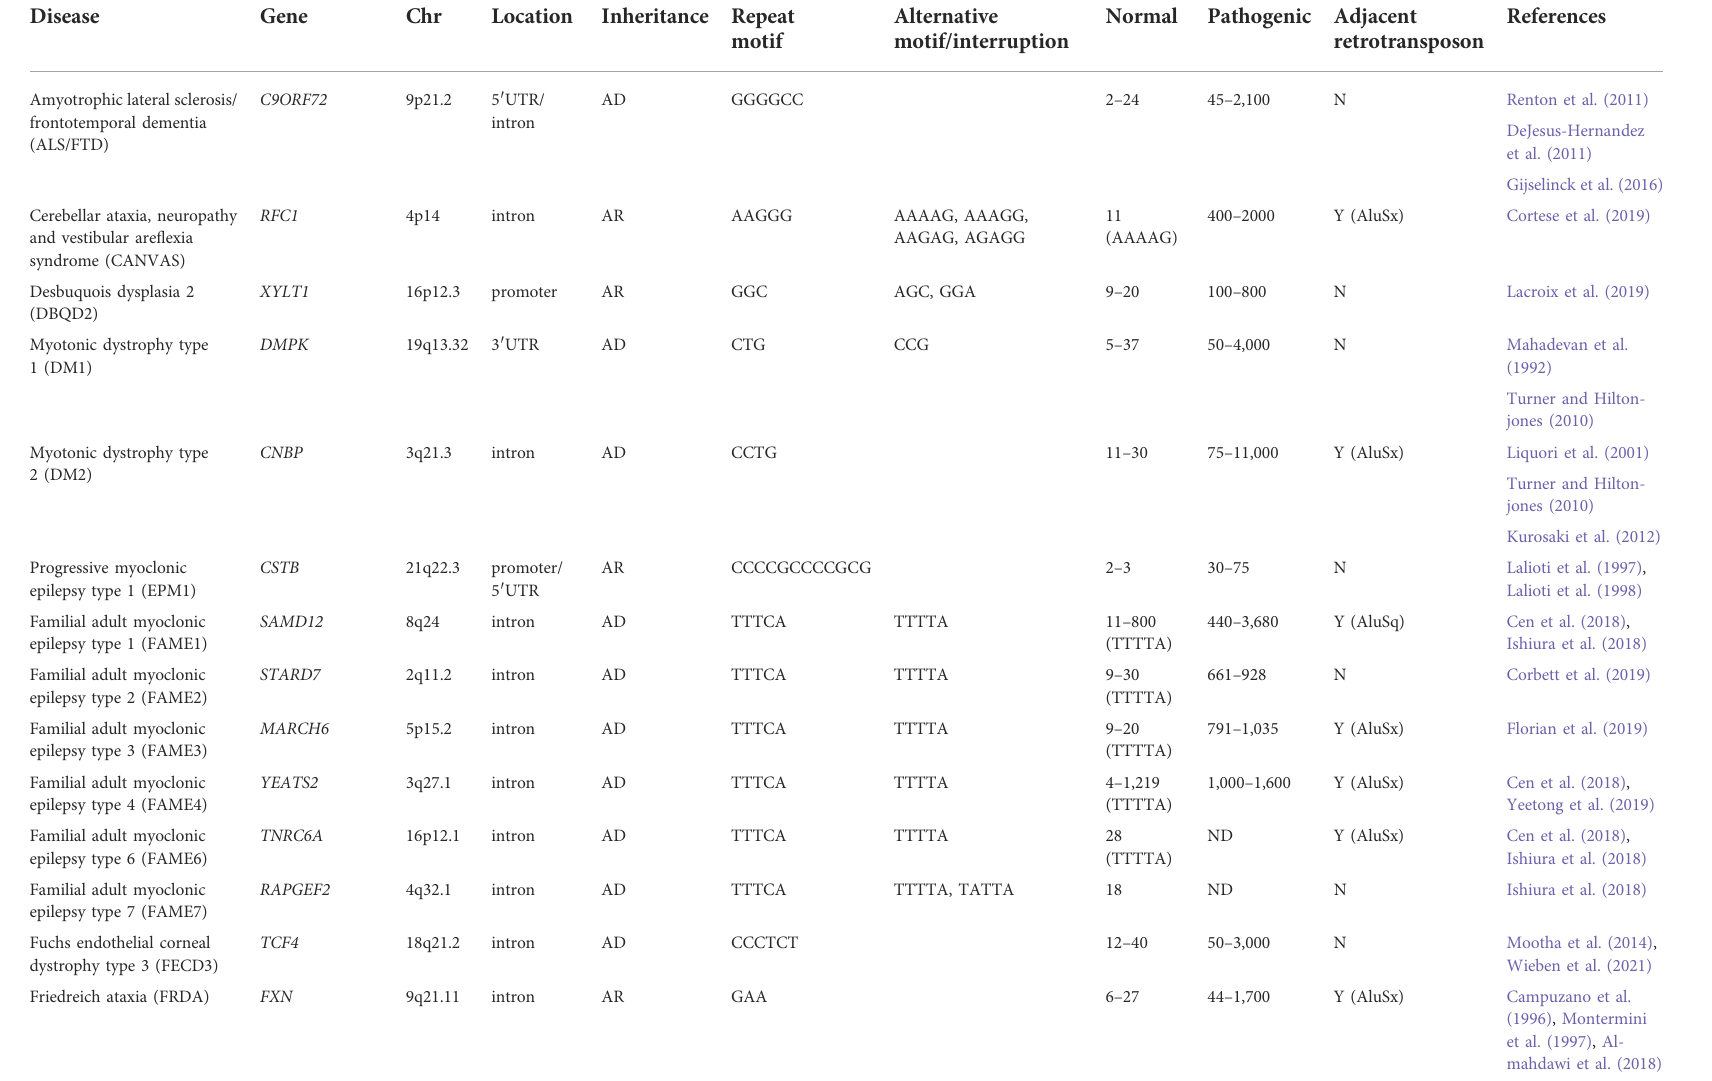
TABLE 1 Noncoding microsatellite repeat expansion